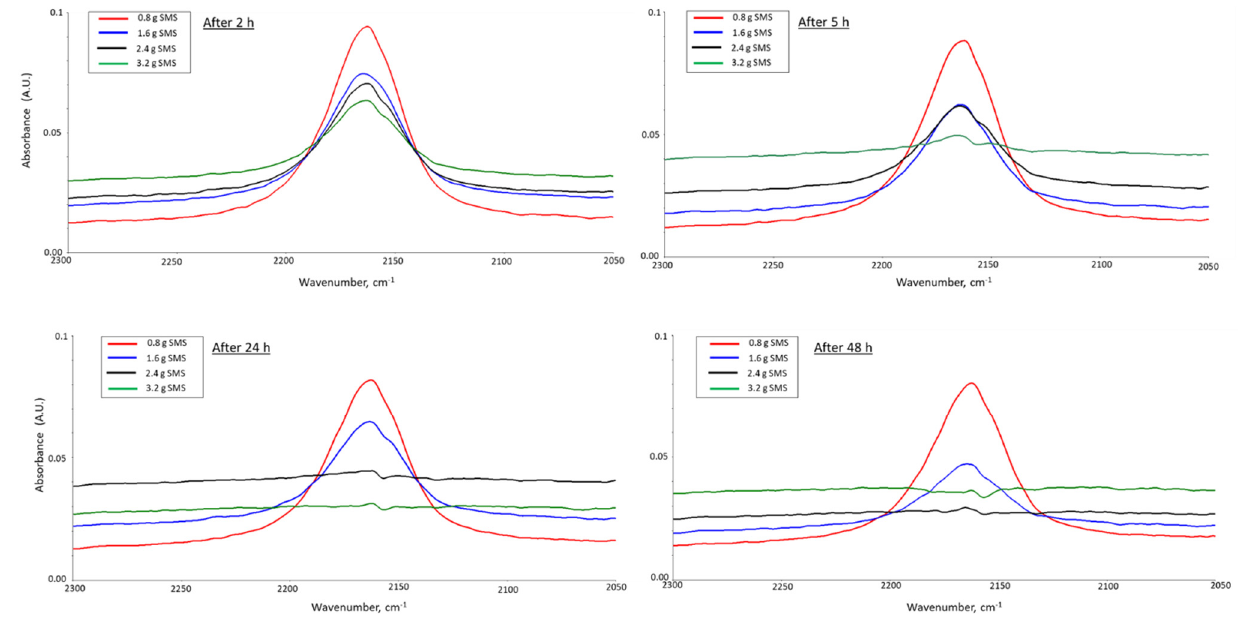
Figure 2. Comparison of spectral features of Si–H band at 2163 cm − 1 after 2, 5, 24, and 48 h for PMHS-treated FCS samples made with various amounts of SMS catalyst.